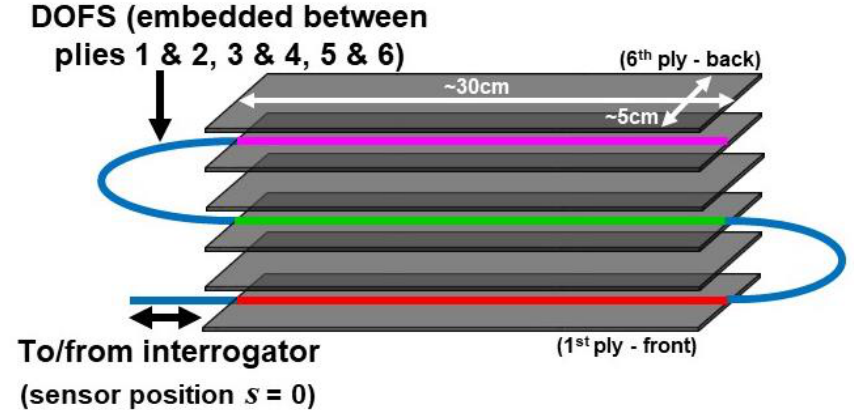
Figure 1. Schematic of beam illustrating distributed optical fiber sensors (DOFS) network between carbon fiber reinforced polymer (CFRP) plies.